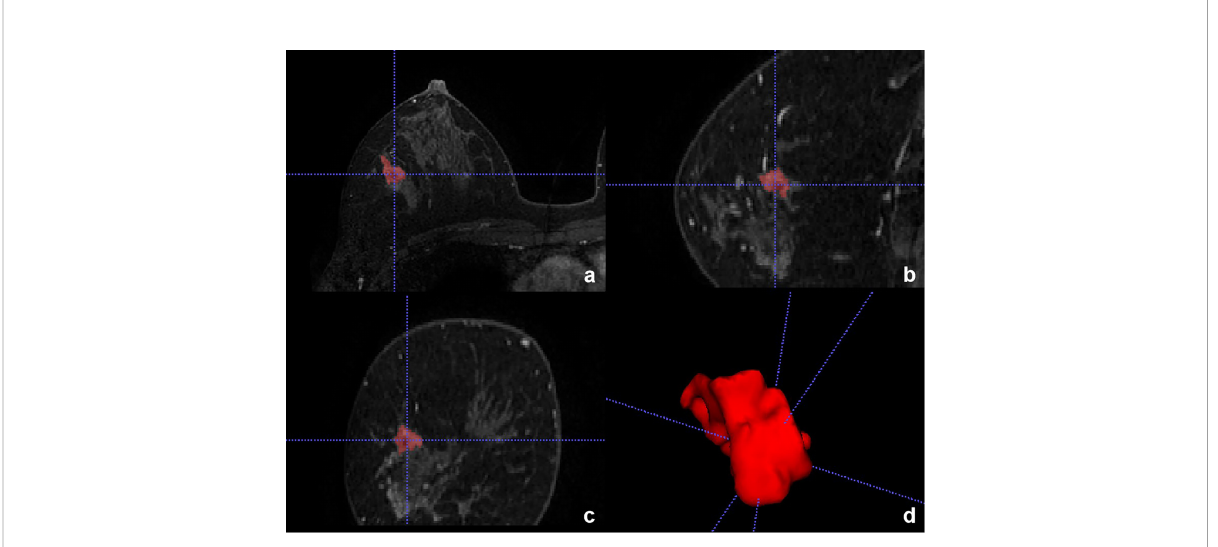
FIGURE 8 Adenosis in a 46-year-old woman in the testing set with false-positive result. (A – C) Axial, Sagittal, and Coronal T1-weighted postcontract image showed non-mass enhancement in the right breast. (D) 3D reconstruction of the